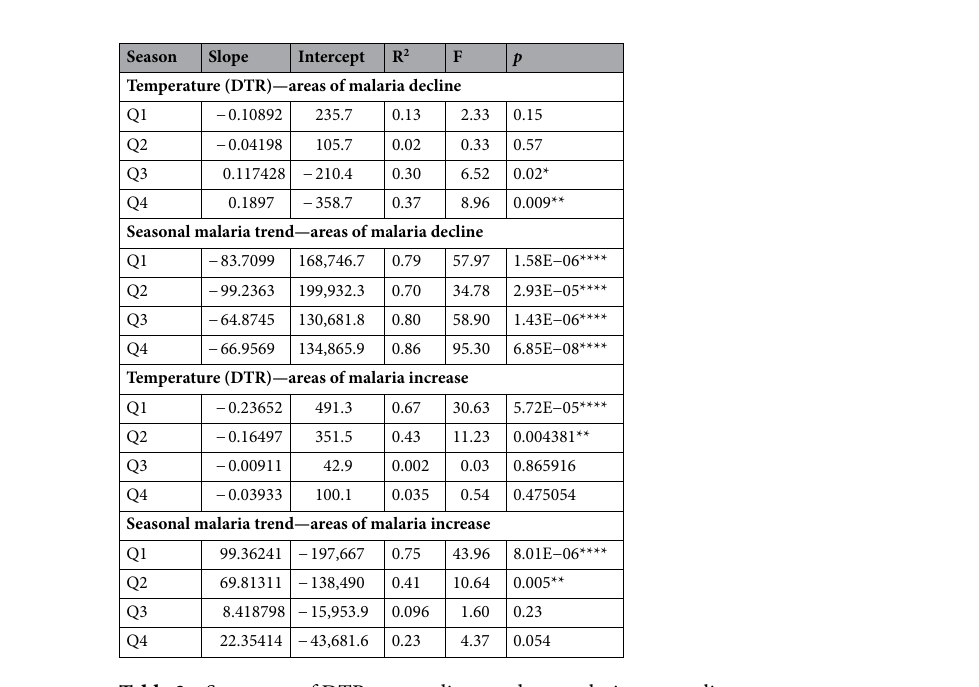
Table 2. Summary of DTR seasonality trends vs malaria